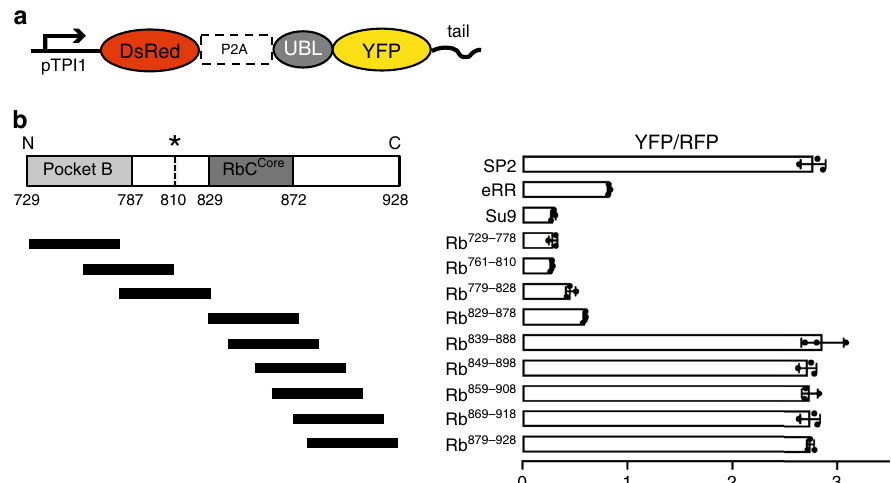
Fig. 3 Proteasome initiation at different Rb sequences. a Schematic representation of the fl uorescence-based degradation assay in S. cerevisiae . The substrate proteins consisted of an N-terminal UBL domain derived from S. cerevisiae Rad23, followed by a YFP domain and a tail. Genes encoding DsRed (RFP) followed by the ribosome skipping sequence P2A and the coding sequence for YFP were expressed from the same promoter (pTPI1) on the same plasmid to produce the RFP reference and YFP substrates at a constant ratio. b Cell fl uorescence pro fi les of S. cerevisiae cultures expressing proteasome substrates with different initiation regions monitored by fl ow cytometry. UBL-YFP substrates with control initiation regions (SP2, eRR, and Su9) or 50 amino acid sequences derived from Rb as indicated. The graph shows standardized median cellular YFP fl uorescence (median YFP/RFP values) ± SD from triplicate experiments. Data are representative of three independent experiments. Source data are provided as a Source Data fi